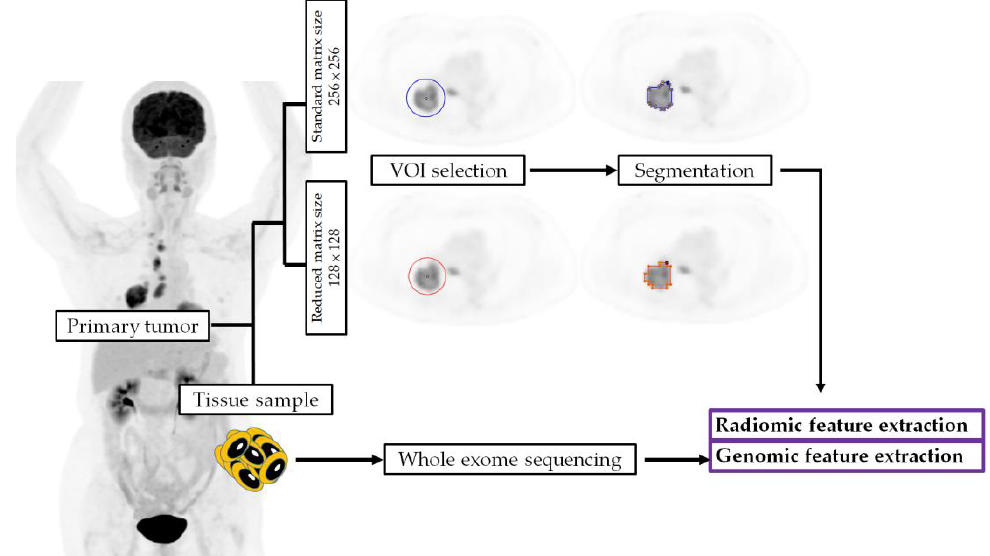
Figure 4. The procedures of radiogenomic feature extraction. VOI, volume of interest.